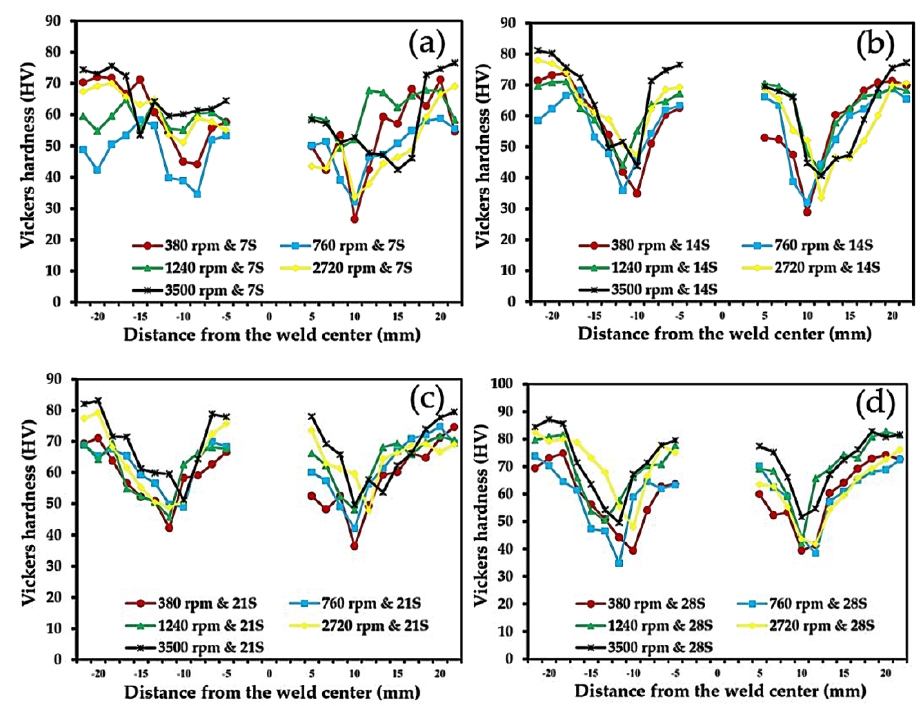
Figure 13. Micro Vickers hardness property of SSM 6061 aluminum alloy by FSSW according to dwell time: ( a ) 7 s, ( b ) 14 s, ( c ) 21 s, and ( d ) 28 s.